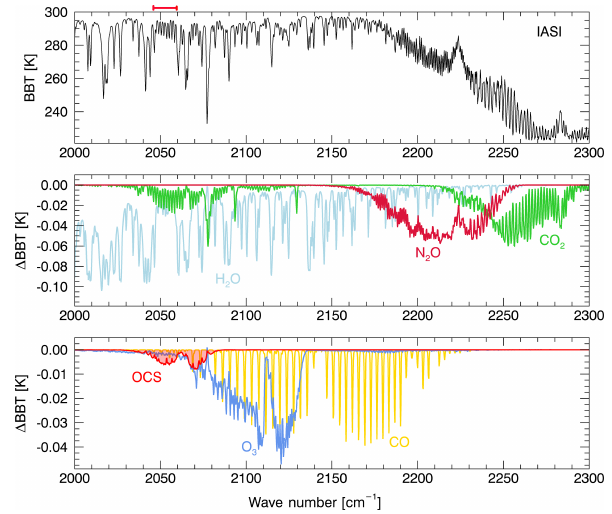
Figure 1. Top shows a simulated IASI BBT spectrum from a desert (i.e. low humidity) atmosphere covering the spectral range used in the linear retrieval. Middle and bottom show Jacobian spectra show- ing the change in BBT for a 1% increase in volume mixing ratio (VMR) for the gases listed. The CO 2 and N 2 O spectra represent tropospheric perturbations, while the remaining four are total col- umn perturbations. The red bar denotes the area between two H 2 O lines where a large portion of OCS information comes